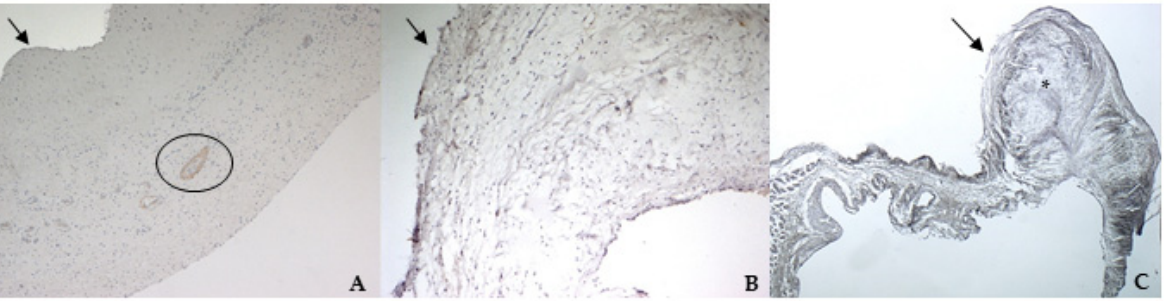
TRPV1 positivity was considered ubiquitous in all samples: it was highlighted in endothelium, endocardium, and spongiosa and fibrosa layers in bovine and both types